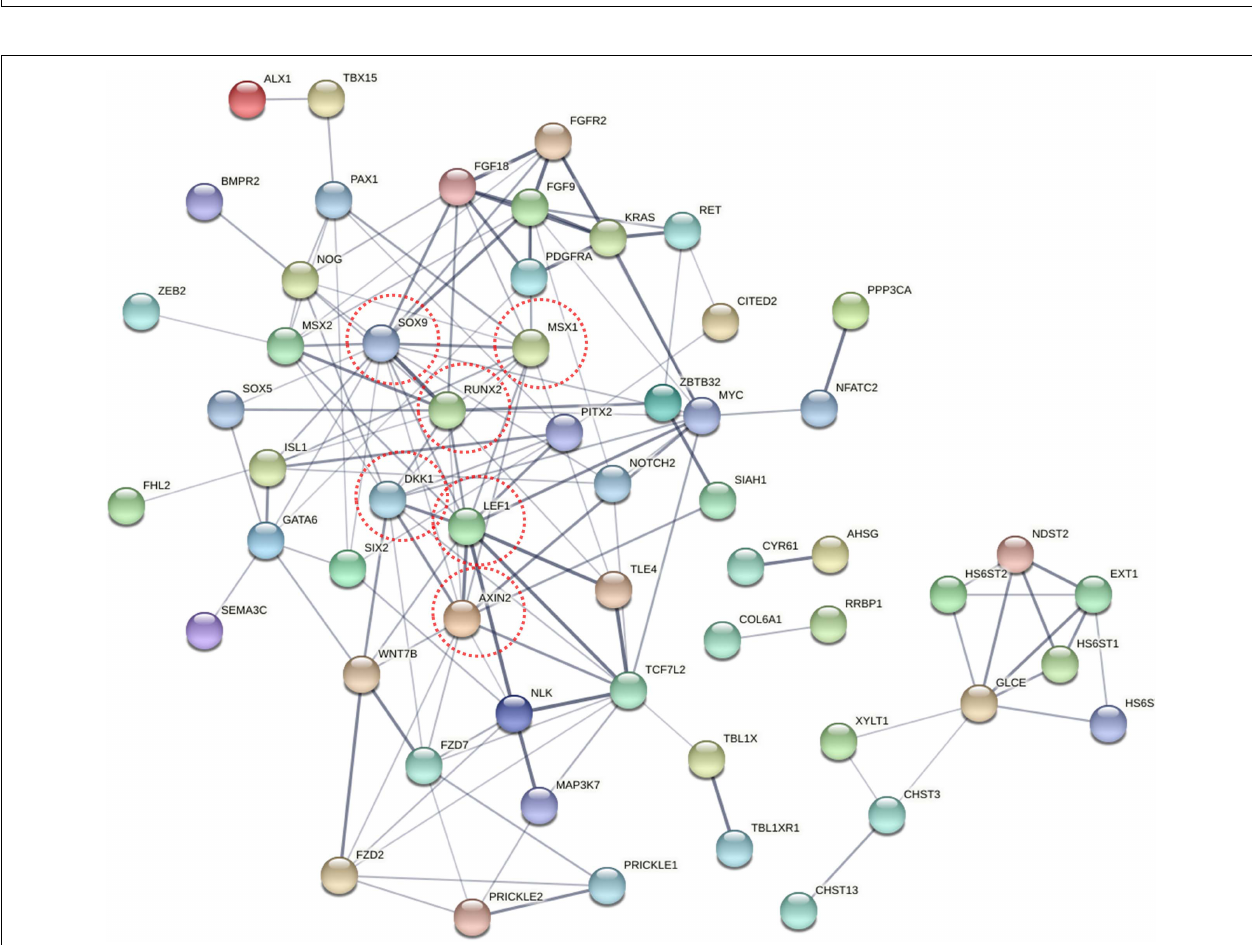
FIGURE 5 | The enriched GO term in biological process related with calcification (A) and top 20 enriched KEGG pathways (B) of CG context differentially methylated genes (DMGs). Numbers in the red circles represent the gene number.